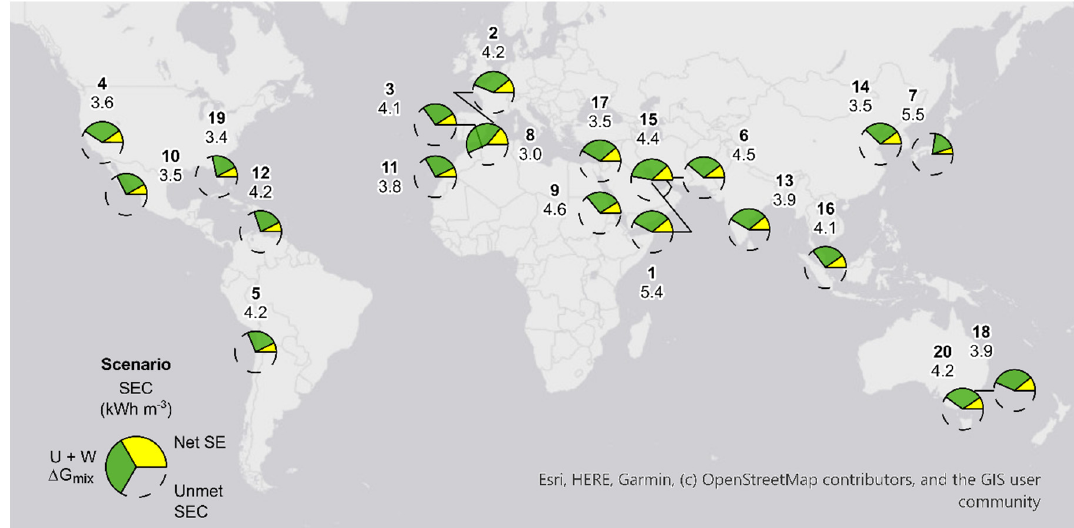
Figure 4. Salinity Gradient Energy share of SWRO desalination plant’s energy consumption. The actual SWRO plant’s SEC value in kWh per m 3 of desalted water is also displayed (relevant references in Table 1).